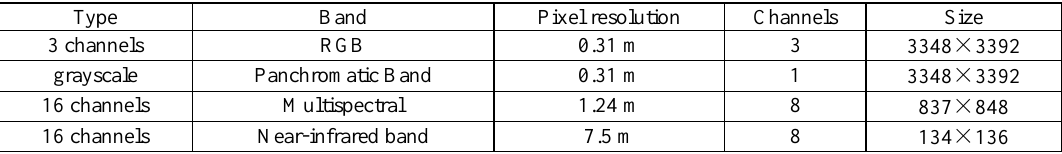
Table 1. Parameters of image.